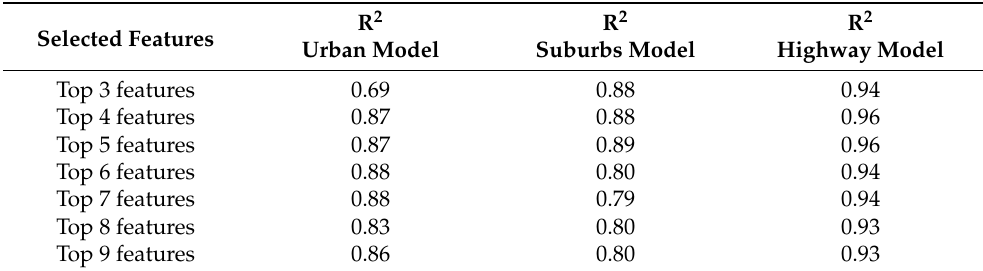
Table 11. Performance statistics results of using NO x models to predict the second route NO x emission.